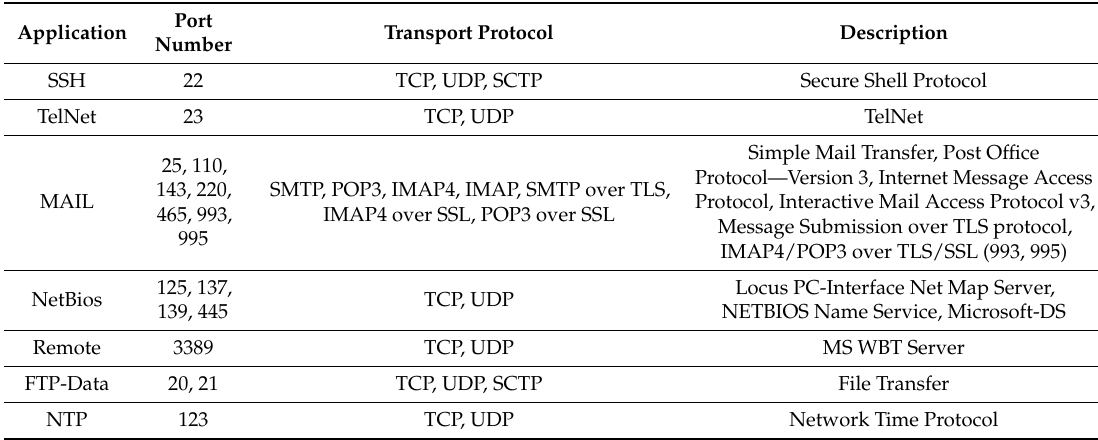
Table 1. Common applications and their corresponding